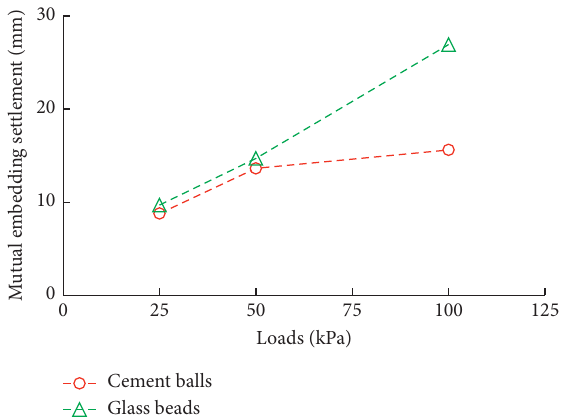
Figure 10: Effects of miscellaneous fill particle material on mutual embedding